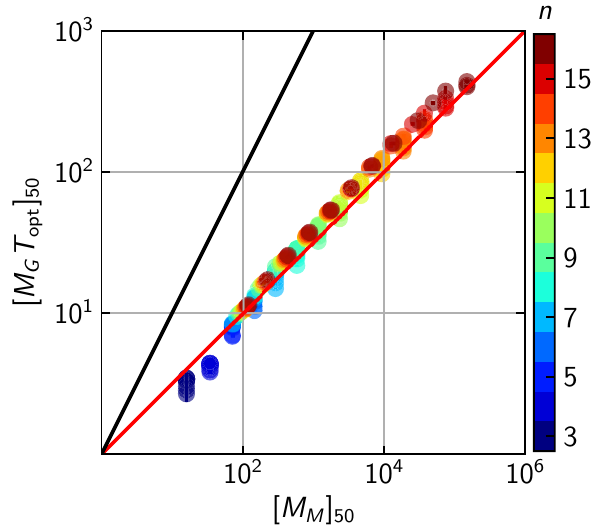
FIG. 9. Speedup scaling over all ( n , k ) , shown by plotting median total Grover iterations versus memoryless search trials required to reach P = 0.99 probability of success. Each point represents a particular ( n , k ) , where n and k each take values over the range [3, 16]. Black and red lines denote linear and square root dependences,